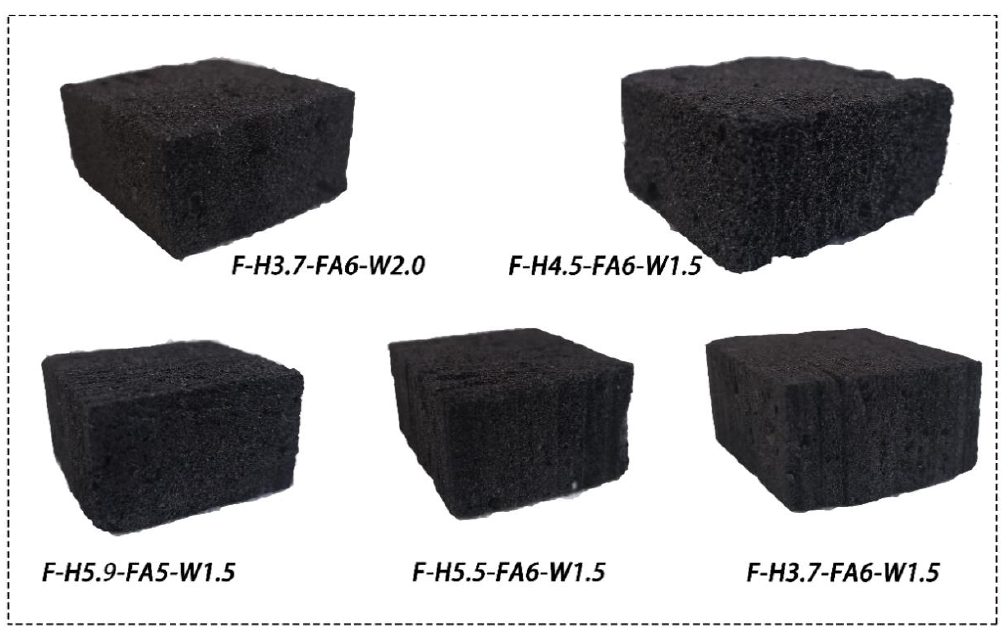
Figure 12. Photographic record of appearance of the experimental tannin–humins foams once cut into cubes.